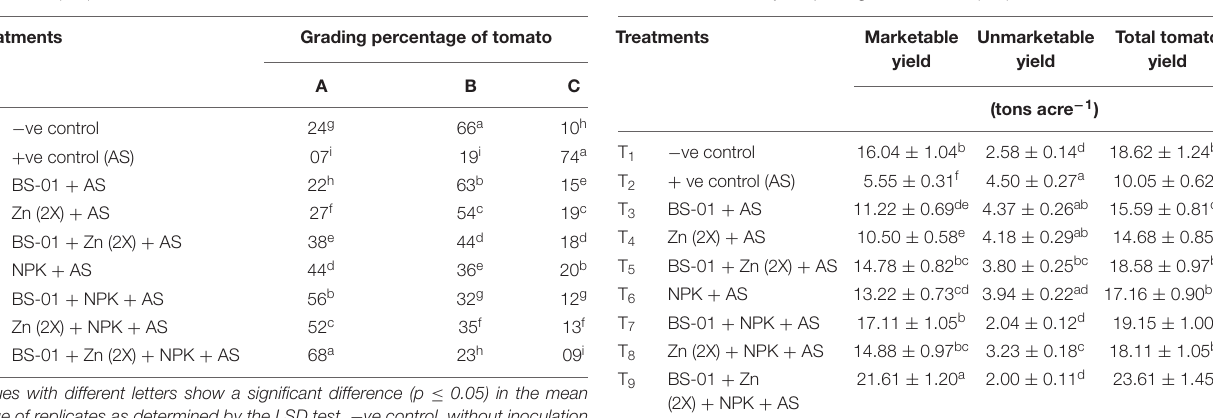
TABLE 7 | Effect of Bacillus subtilis (BS-01) and mineral nutrients [Zn (2X: 10 kg acre − 1 ) and NPK (64:46:50 kg acre − 1 )] on the marketable, unmarketable, and total yield (tons acre − 1 ) of tomato plants inoculated with Alternaria solani (AS) in the field after 160 days of pathogen inoculation